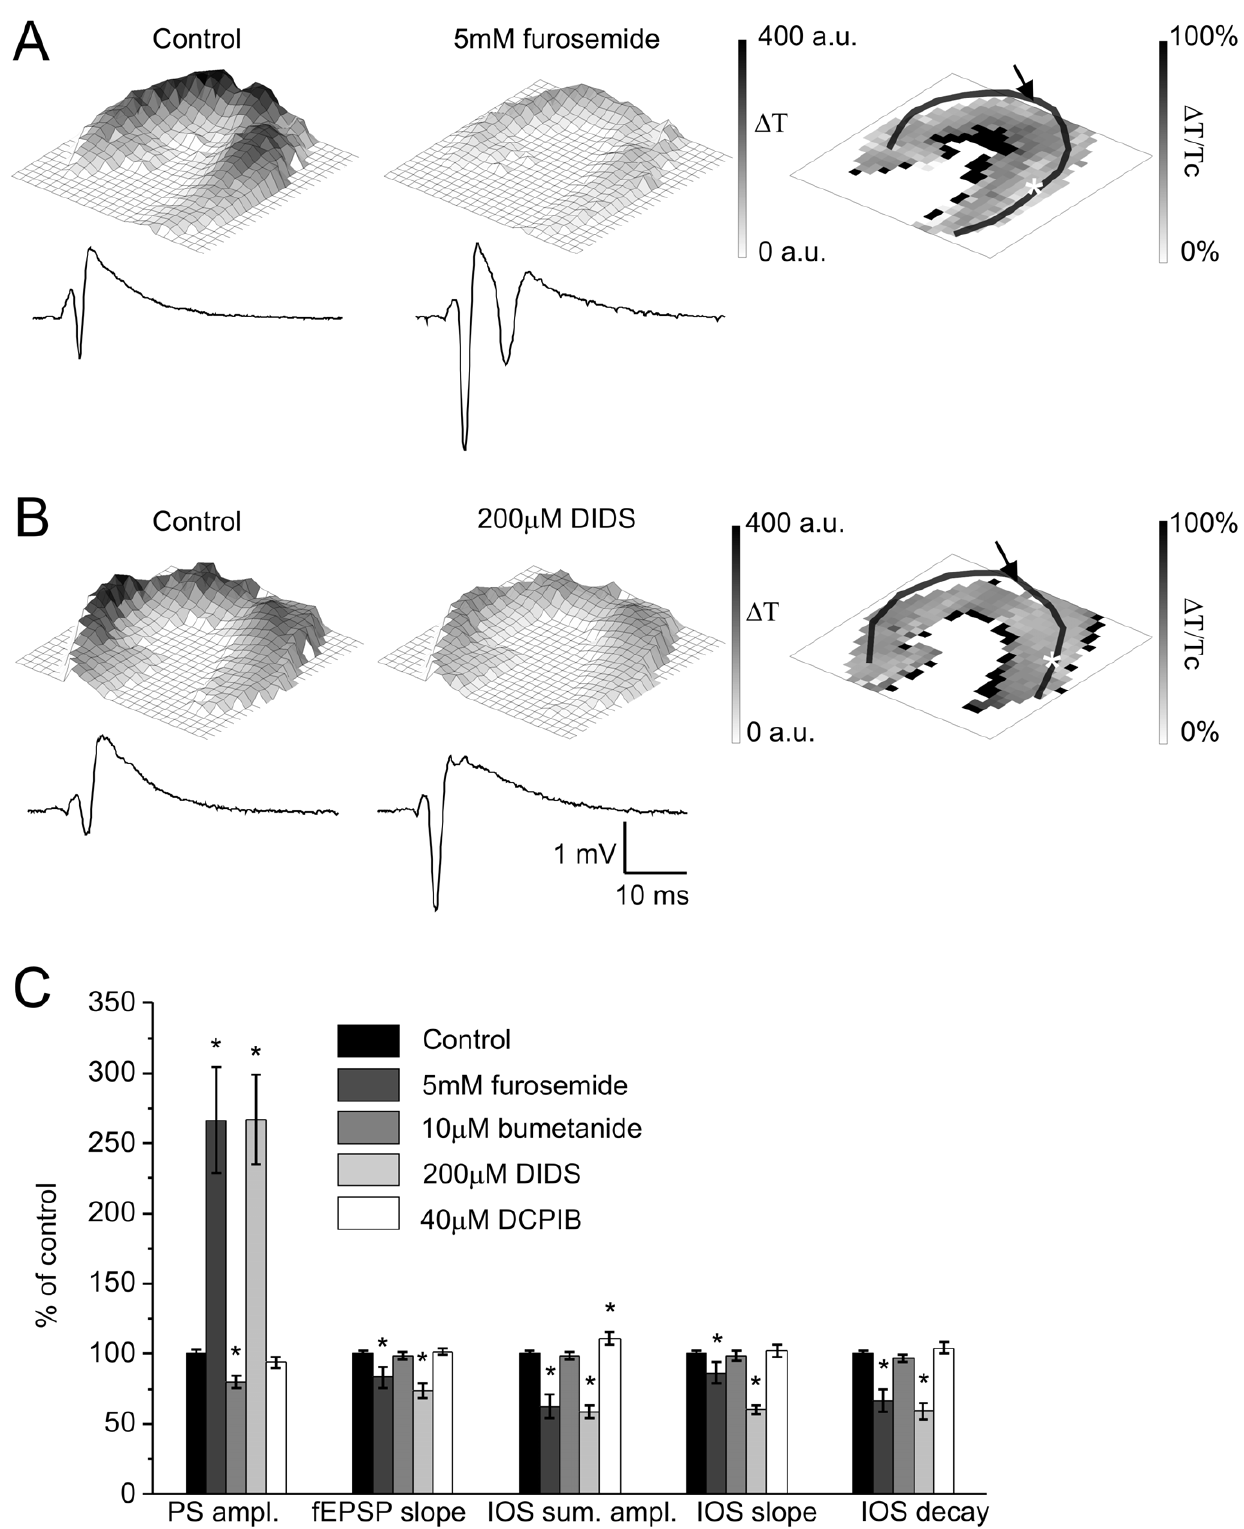
Figure 5. Neuronal K + /Cl 2 cotransporter, non-specific Cl 2 and volume-regulated anion channels contribute to IOS. A Left and Middle: Representative IOS amplitude map and field response curve under control condition and 5 mM furosemide application, respectively. The colorbar indicates the maximum change of the transmittance compared to the resting light intensity. A Right: Spatial visualization of the percentage of control changes of IOS signal caused by furosemide application. B Left and Middle: Representative IOS amplitude map and field response curve under control condition and 200 m M DIDS application, respectively. The colorbar indicates the maximum change of the transmittance compared to the resting light intensity. B Right: Spatial visualization of the percentage of control changes of IOS signal caused by DIDS application. C: The effect